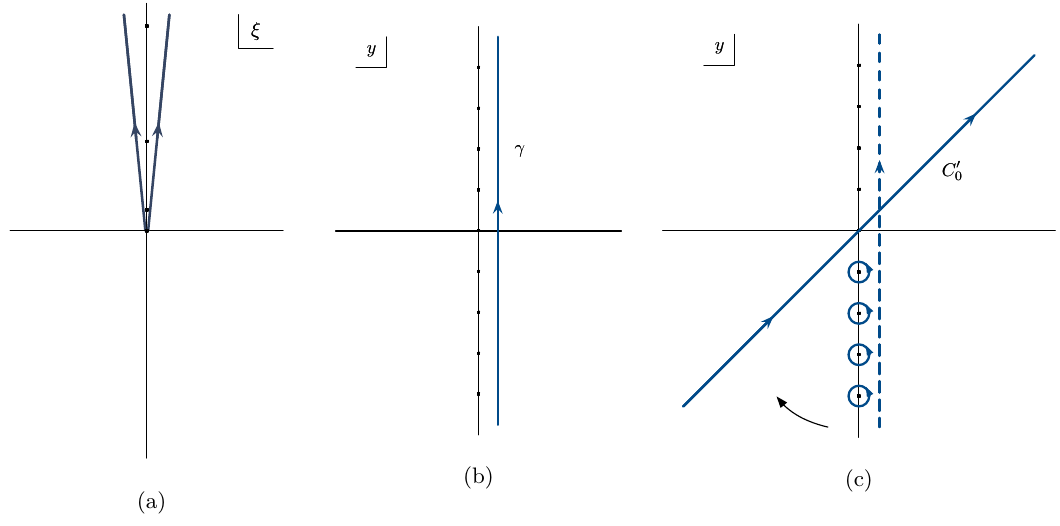
Figure 1. The integration